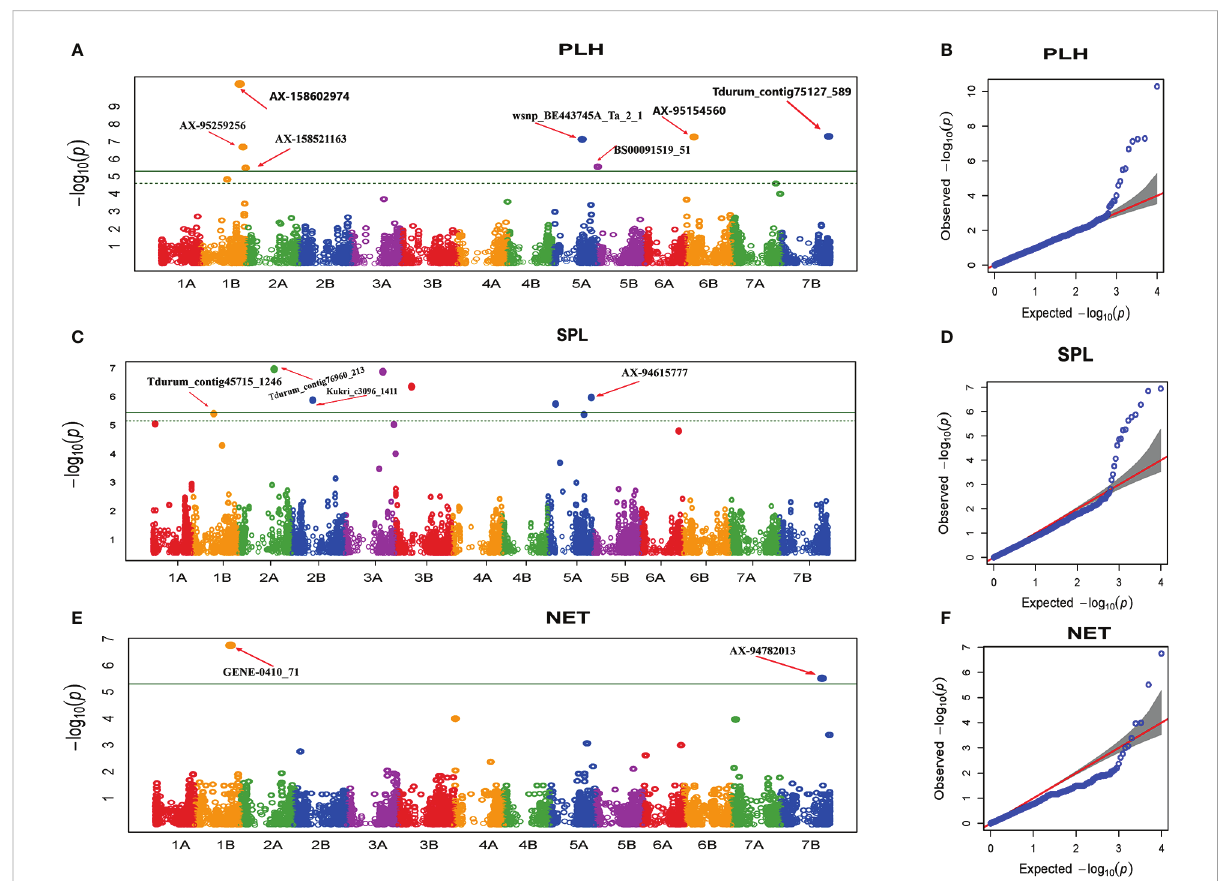
FIGURE 6 Manhattan and Q-Q plots of GWAS scan for plant architecture traits generated based on the combined data from fi ve locations. PHT (A, B) , SPL (C, D) , NET (E, F) . For the Manhattan plots, the y-axis represents -log10 (p) of the traits, while the x-axis represents the relative positions of the SNP markers on each chromosome. PHT, Plant height; SPL, Spike length; NET, Number of effective tillers per